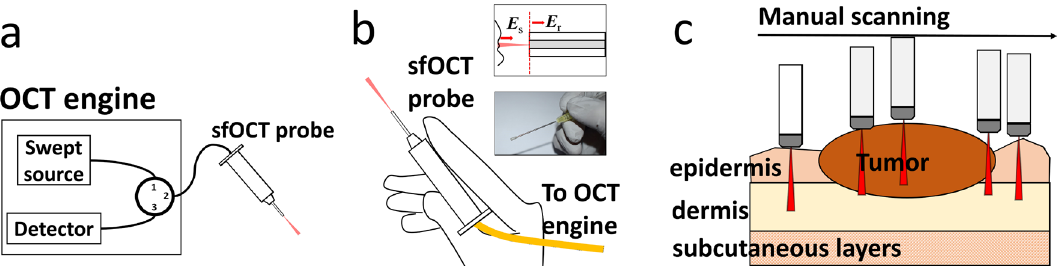
Figure 1. ( a ) Swept source OCT system; ( b ) handheld sfOCT probe (upper inset: reference light derives from the probe tip; lower inset: a photo of the probe held by hand); ( c ) sfOCT probe is manually scanned across a region of interest to generate a 2D